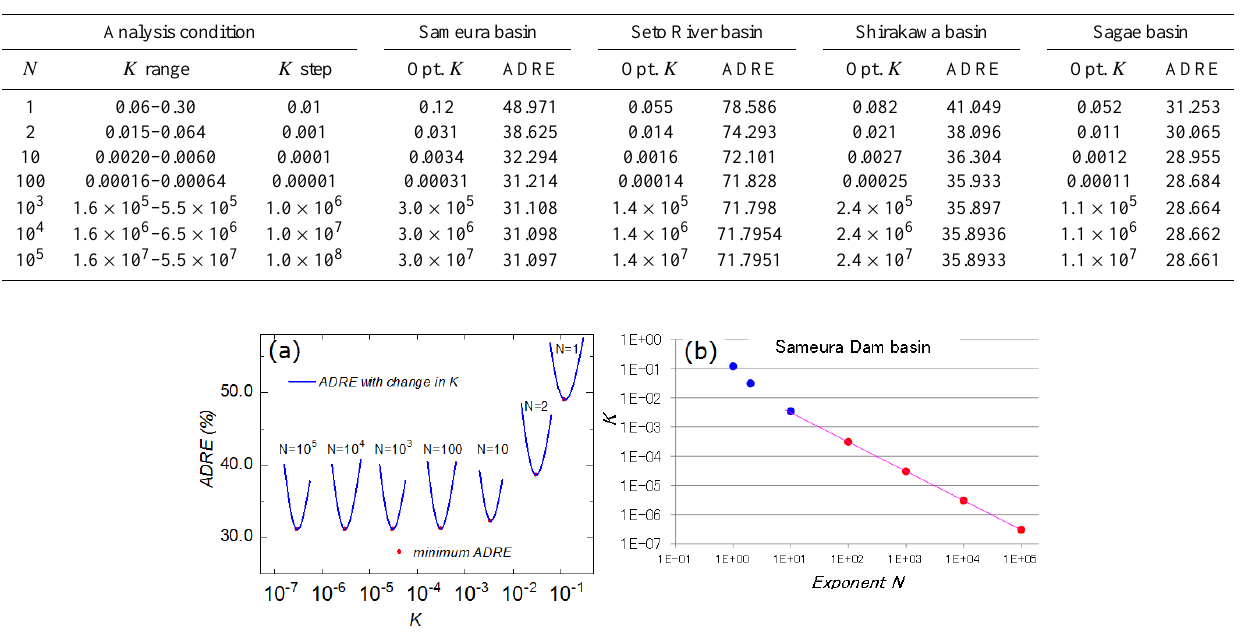
Figure 3. Relationship between K and minimum ADRE (a) , and relationship between exponent N and constant K in the log–log graph (b) for the Sameura Dam basin.